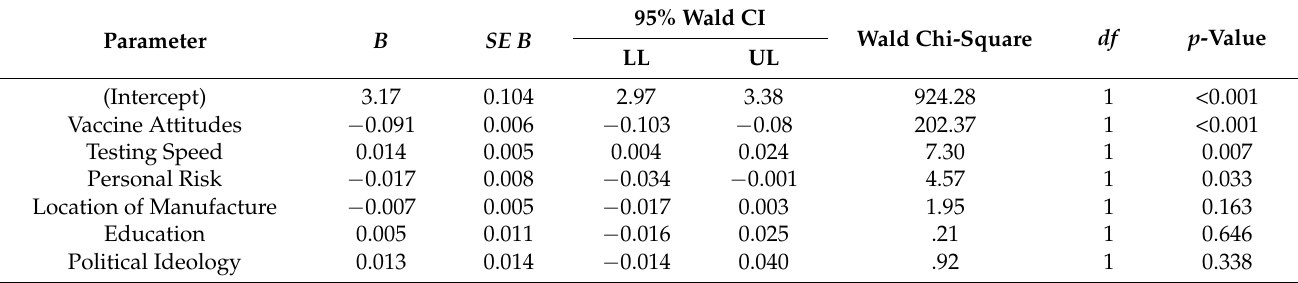
Table 3. Multiple Regression